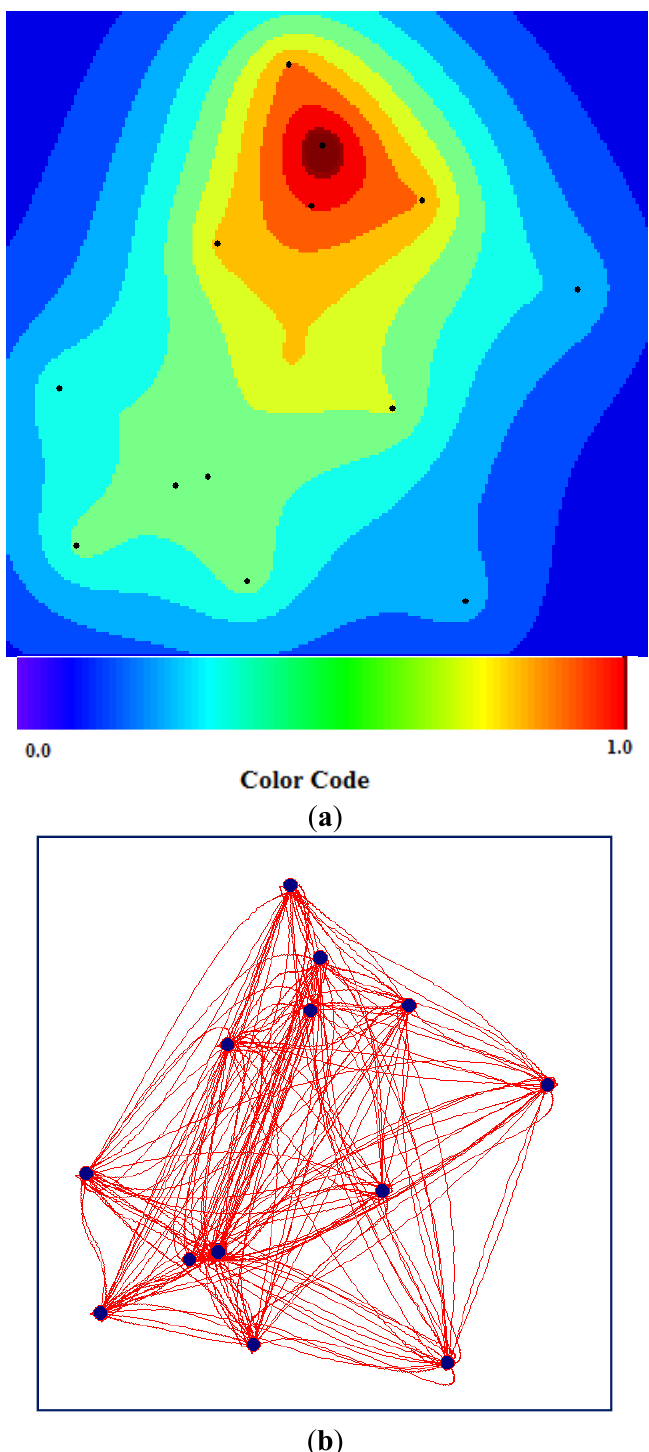
Figure 15. ( a ) TWC- γ Map where the darker the red, the higher the concentration of epidemics (the darkest red zone represents approximately 1/1,000 of the whole area). ( b ) TWC- γ rebuilt all the possible paths among the 13